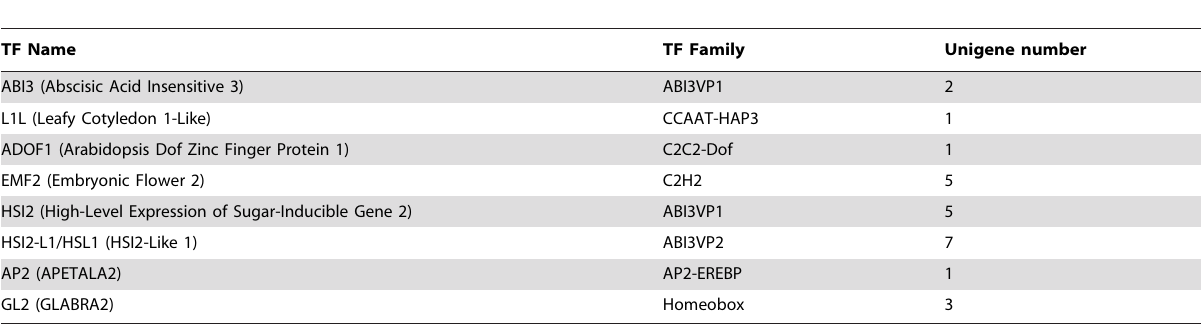
Table 5. Putative transcription factors related to the oil biosynthesis in yellow